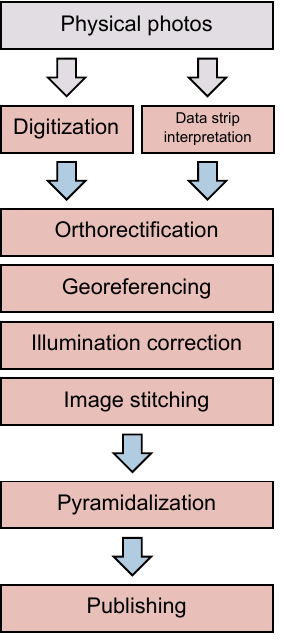
This picture summarizes the entire working process (manual, automatic and semi-automatic steps) from original photos to Web publication. The four blocks in the middle are steps that can be merged or performed in a different order, depending on the actual